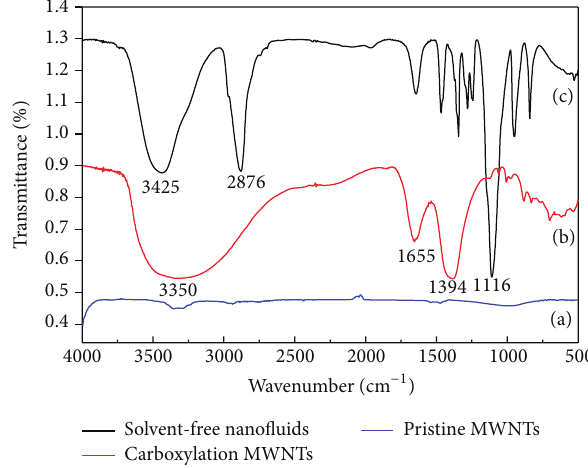
Figure 2: FTIR curves of MWNTs and nanofluids